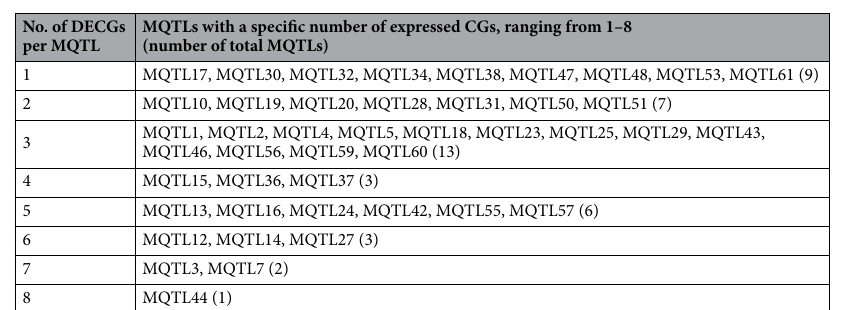
Table 3. A list of differentially expressed CGs (DECGs) identified through in silico expression analysis. For details of all the CGs see Tables S3 and S4.